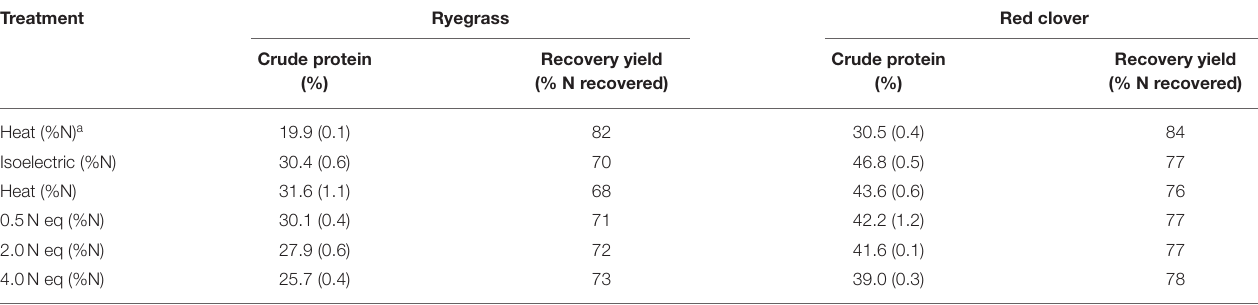
TABLE 2 | Relative amount of crude protein in protein concentrate on a DM basis from cleared juice and total recovery yield of N from the juice including the clearing. Treatment Ryegrass Red clover Crude protein Recovery yield Crude protein Recovery yield (%) (% N recovered) (%) (% N